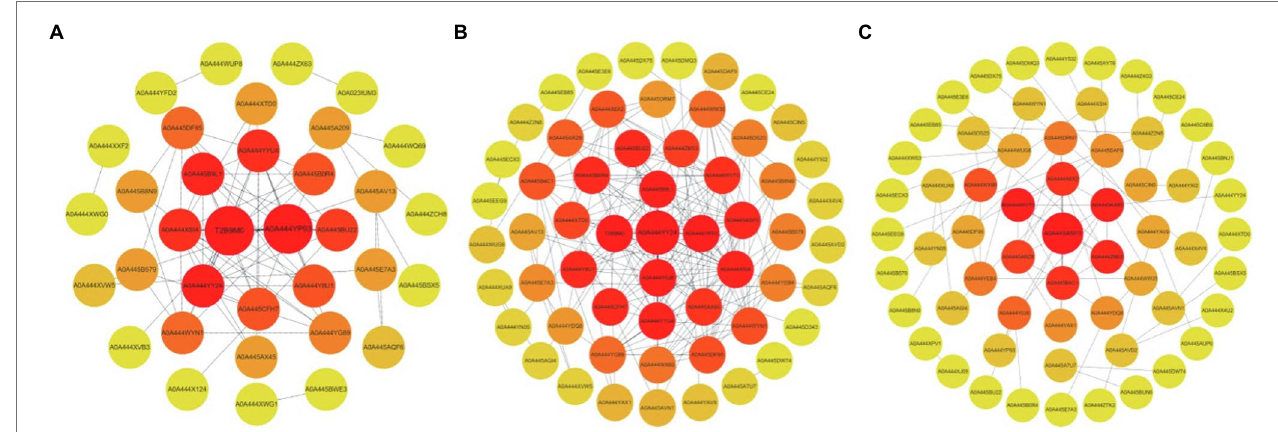
FIGURE 7 | The protein-protein interaction (PPI) network interaction map of the differentially accumulated proteins (DAPs) in two peanut cultivars after 12 days of waterlogging treatment. (A) PPI interaction network map of hub DAPs between ZH4 and its control group after 12 days of waterlogging treatment; (B) PPI interaction network map of hub DAPs in XH08 and its control group after 12 days of waterlogging treatment; (C) PPI interaction network map of hub DAPs between XH08 and ZH4 subjected to waterlogging treatment.